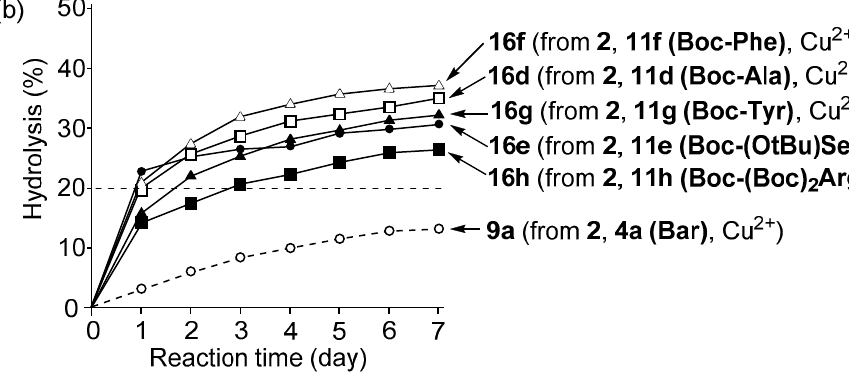
Figure 4. Hydrolysis of MNP (100 μ M in the total solution) by ( a ) 9a (open circles with dashed curve), 16i (open squares), 16j (closed circles), 16k (open triangles), 16l (closed triangles), or 16m (closed squares) ([ 9 , 16 ] = 20 μ M in the total solution); ( b ) 9a (open circles with dashed curve), 16d (open squares), 16e (closed circles), 16f (open triangles), 16g (closed triangles), or 16h (closed squares) ([ 9 , 16 ] = 20 μ M in the total solution) in CHCl 3 /50 mM HEPES buffer (pH 7.4) with I = 0.1 (NaNO 3 ) (2/8) at 37 °C. The concentrations of the product (4-nitrophenol) were determined in the total two-phase solvent system.